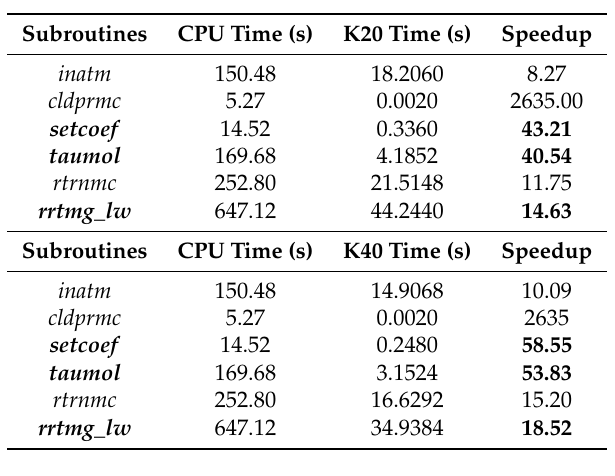
Table 3. Run-time and speedup of the 2-D G-RRTMG_LW on one GPU, where the block size = 128 and ncol =